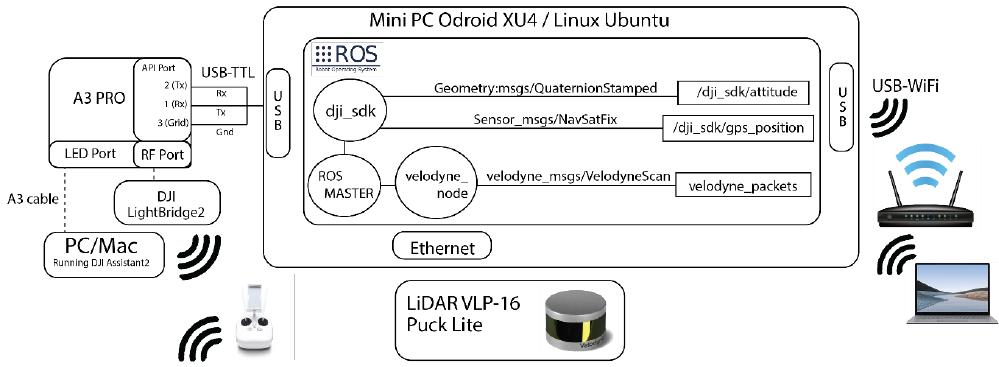
Figure 7. LiDAR communications scheme for collecting data.